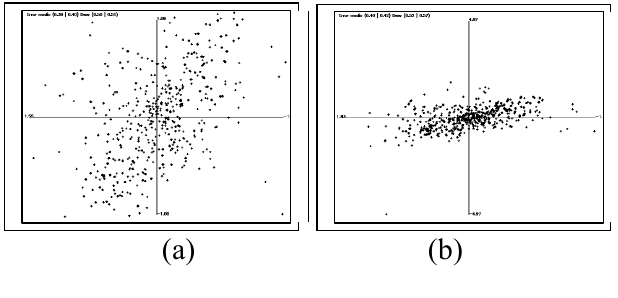
Figure 15. Errors between the theoretical projection and the real projection of the points of the pattern in the image for (a) the initial calibration (b) refined results.